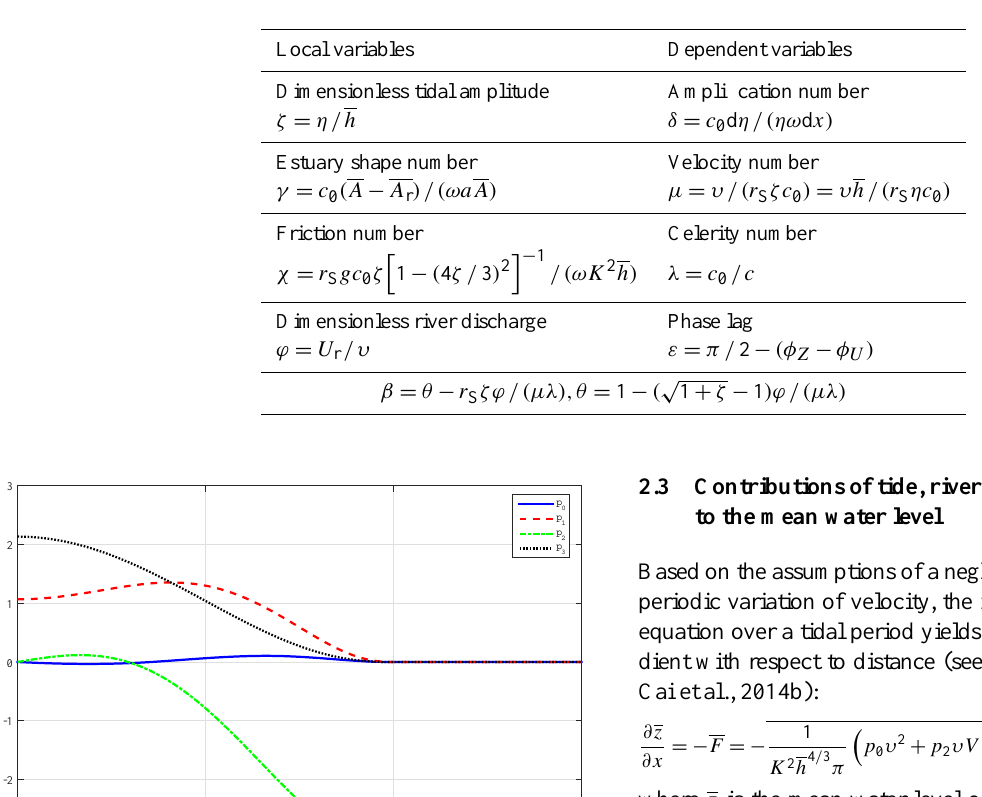
Table 1. Definitions of parameters used in the governing Eqs. (6), (14), (15), and (16).